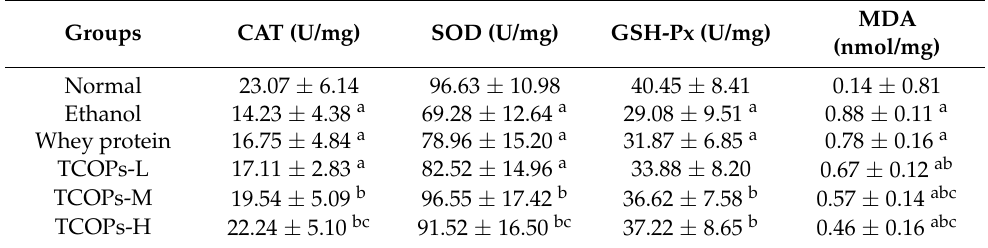
Table 4. Effects of TCOPs on antioxidant and lipid peroxidation index in gastric tissue of rats.